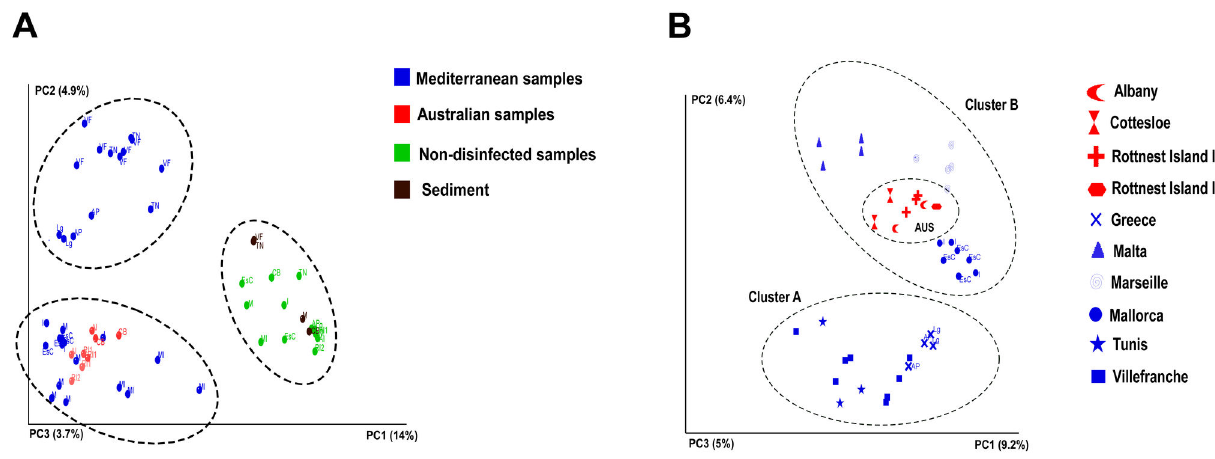
Figure 1. PCA representing weighted Unifrac analysis of C. racemosa samples from Mediterranean Sea and Australia (invaded and native range), A-All samples including controls; B-Disinfected samples only. Sample Codes: Al - Albany (Australia), CB - Cottesloe Beach (Australia), Lg - Liguria (Greece), AP - Agios Pavlo (Greece), Ml - Malta, M-Marseille, I - Illetas (Mallorca, Spain), EsC - Es Cargol (Mallorca, Spain), RI1 - Rottnest Island 1 (Australia), RI2 - Rottnest Island 2 (Australia), TN - Tunisia, VF - Villefranche (France). doi: